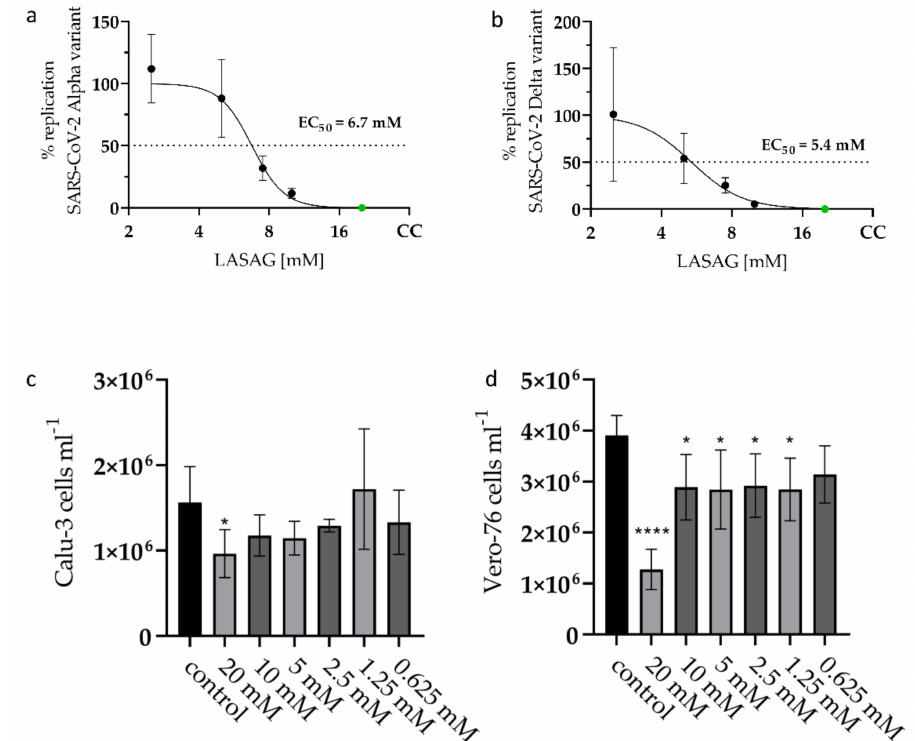
Figure 1. LASAG inhibits SARS-CoV-2 replication at non-toxic concentrations in vitro. ( a , b ) Calu-3 cells were left untreated or were incubated with the indicated concentrations of LASAG for 1 h. Subsequently, cells were infected with the SARS-CoV-2 variants (( a ) Alpha (isolate 5159); ( b ) Delta (isolate 4749)) at 0.5 MOI (=multiplicities of infection) in the absence and presence of LASAG for 2 h. After a medium change, cells were further incubated in the absence and presence of LASAG. At 24 h post infection (p.i.), progeny virus titers were determined in the supernatant by standard plaque assay. The virus titers of control-infected cells were arbitrarily set to 100%. Shown are the means ( ± SD) of three independent experiments including two biological samples. EC 50 were calculated by a 4 parameter nonlinear fit in Graphpad prism. ( c , d ) Calu-3 ( c ) and Vero-76 ( d ) cells were cultivated for 24 h in the absence and presence of LASAG. The cell viability was evaluated by cell counting. Shown are the means ( ± SD) of viable cells of three independent experiments including two biological samples. Statistical significance was analyzed by ordinary one-way ANOVA followed by Dunnett’s multiple comparisons test (*, p < 0.0332; ****, p <